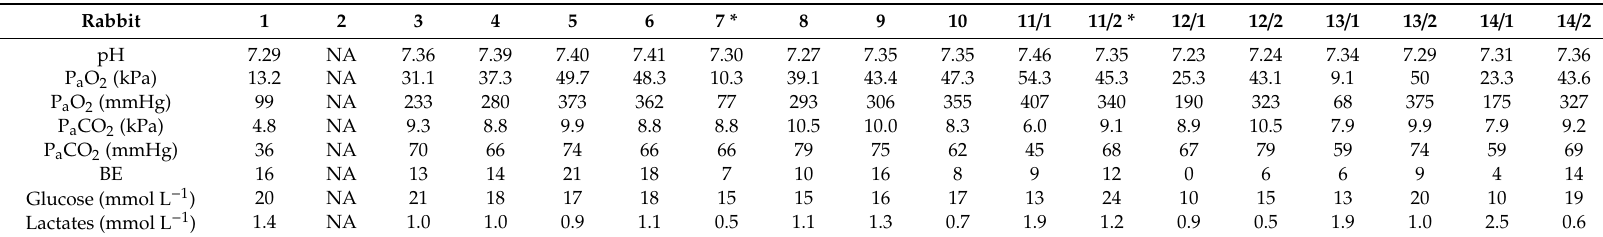
Table 4. Intraoperative individual arterial blood gas analysis of 13 rabbits (1-3-4-5-6-7-8-9-10-11 / 2-12 / 2-13 / 2-14 / 2) undergoing surgical creation of critical-sized defects in the calvarial bone, approximately 45 min after administration of medetomidine, ketamine and buprenorphine subcutaneously with or without isoflurane. Additional arterial blood gas was analyzed in rabbits 11, 12, 13 and 14 approximately 15 to 20 min after injection (11 / 1-12 / 1-13 / 1-14 /